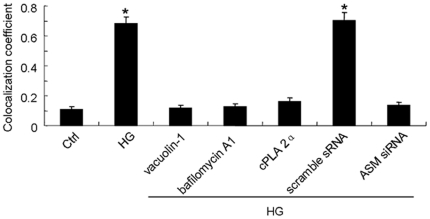
Summarized data on the colocalization of LRs with gp91phox in different groups.HG incubation increased the proportion of LRs colocalized by gp91phox significantly in normal or scramble sRNA transfected cell. But in vacuolin-1, bafilomycin A1 or cPLA 2α pretreated and ASM siRNA transfected cell, HG incubation did not change the level of colocalization between LRs and gp91phox as compared to that in Ctrl cell. Values are means±SE; n = 5 batches of cells. * P<0.05 vs. Ctrl.